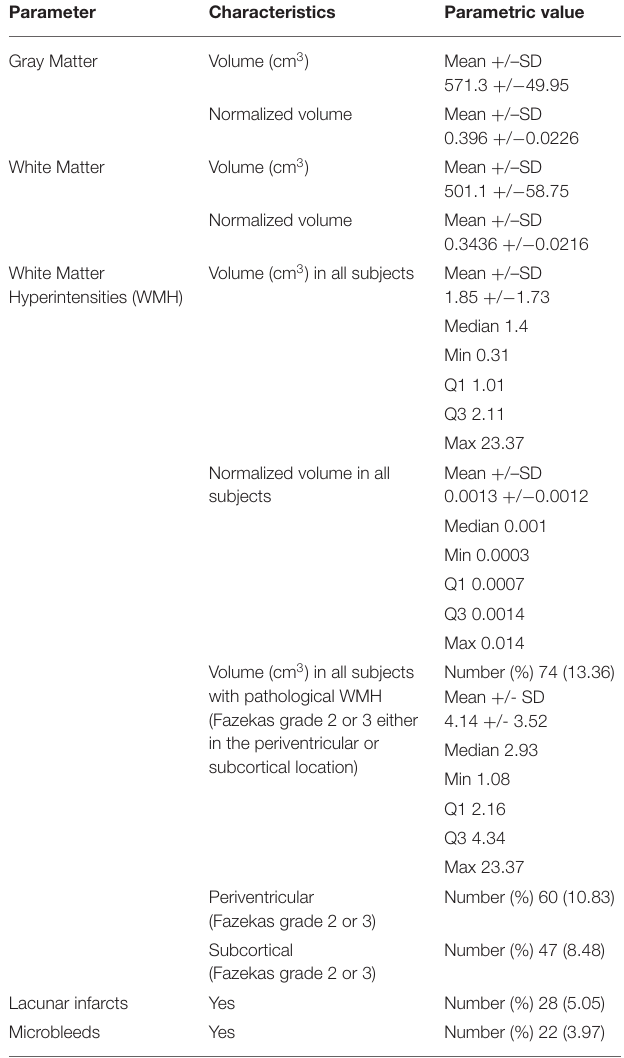
TABLE 2 | Volumetric measurements of the gray and white matters as well as cerebral small vessel disease characteristics derived from brain